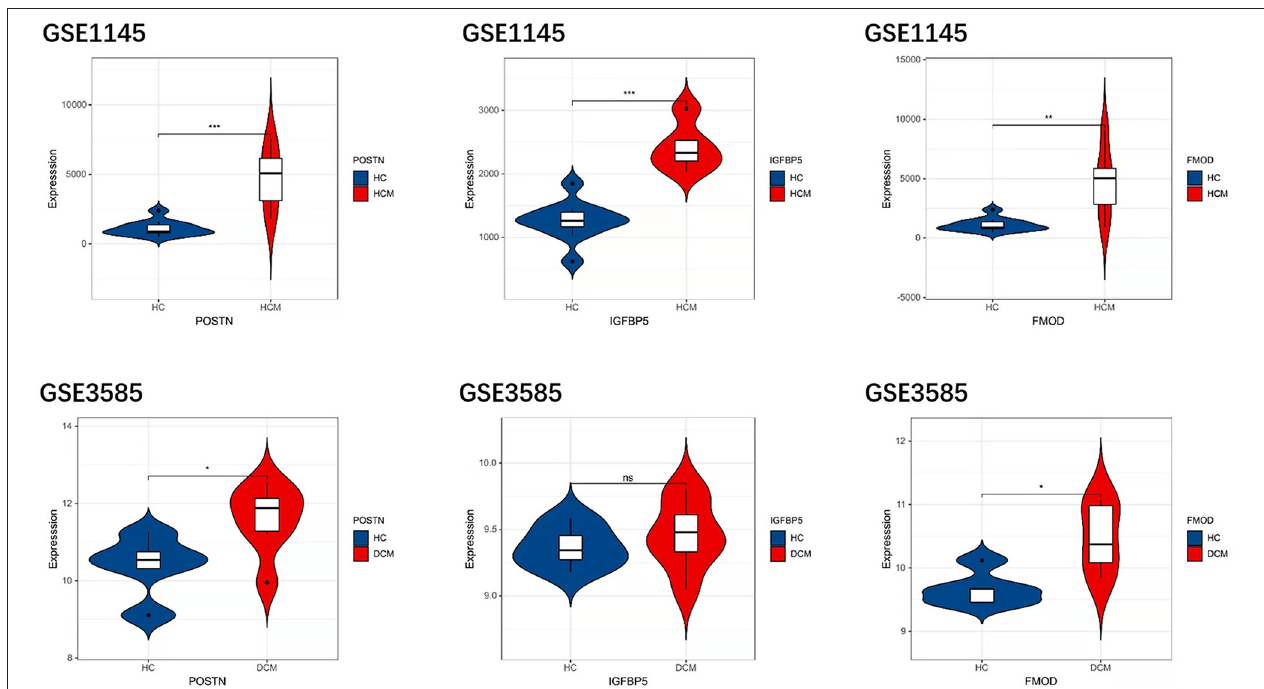
FIGURE 8 | The expression levels of hub genes in GSE1145 and GSE3585. The comparison between the two sets of data used the mean t -test. P < 0.05 was considered to be statistically significant. HC, healthy control. * P < 0.05; ** P < 0.01; *** P <